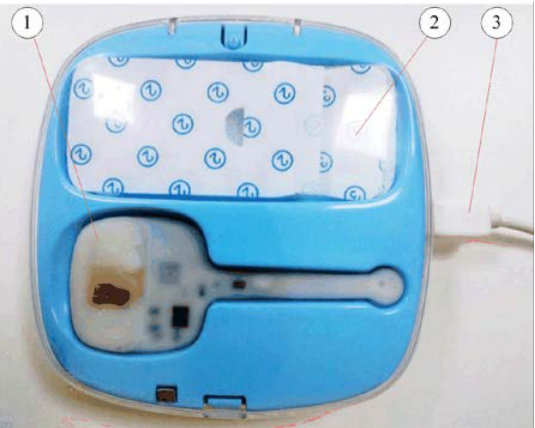
Figure 12. The developed smart thermometer product: (1) the Bluetooth thermometer, (2) the monitor screen, and (3) an extra charging port.